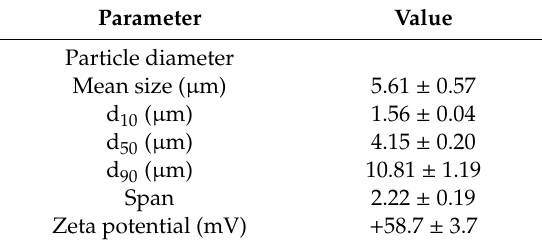
Table 1. The formed CM exhibited mean and median (d 50 ) size of 5.61 ± 0.57 µ m and 4.15 ± 0.20 µ m, respectively, polydispersity of 2.22 ± 0.19, and high positive zeta potential ( + 58.7 ± 3.7). Table 1. Physicochemical characteristics of spray-dried chitosan microparticles. Parameter